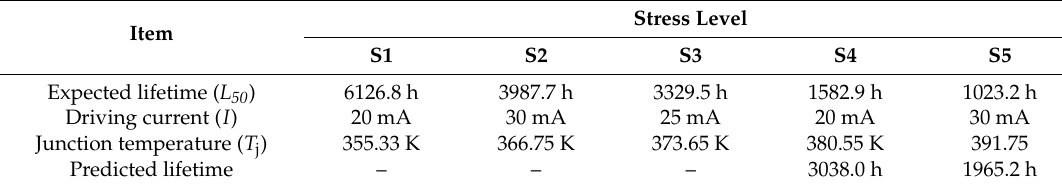
Table 2. Independent variables for model